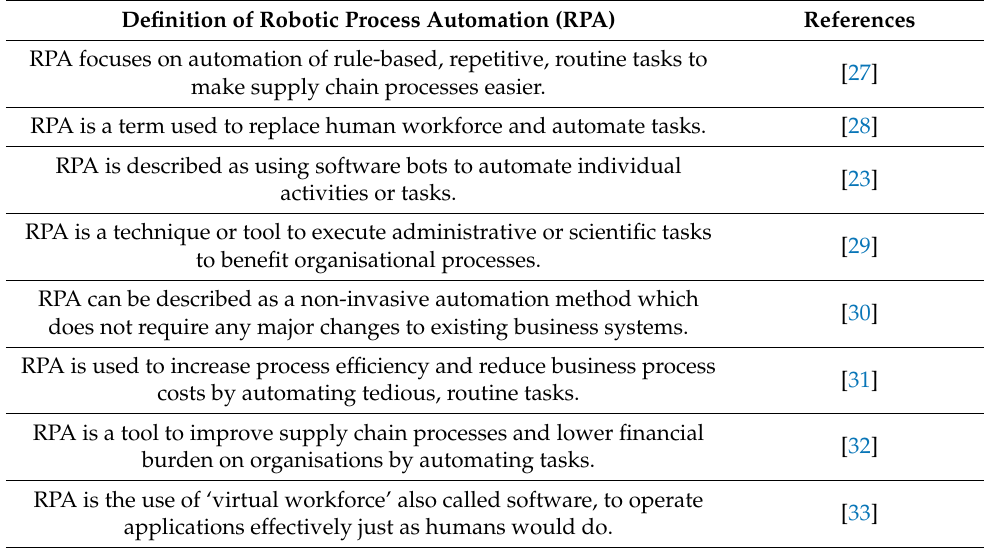
Table 1. Definitions of Robotic Process